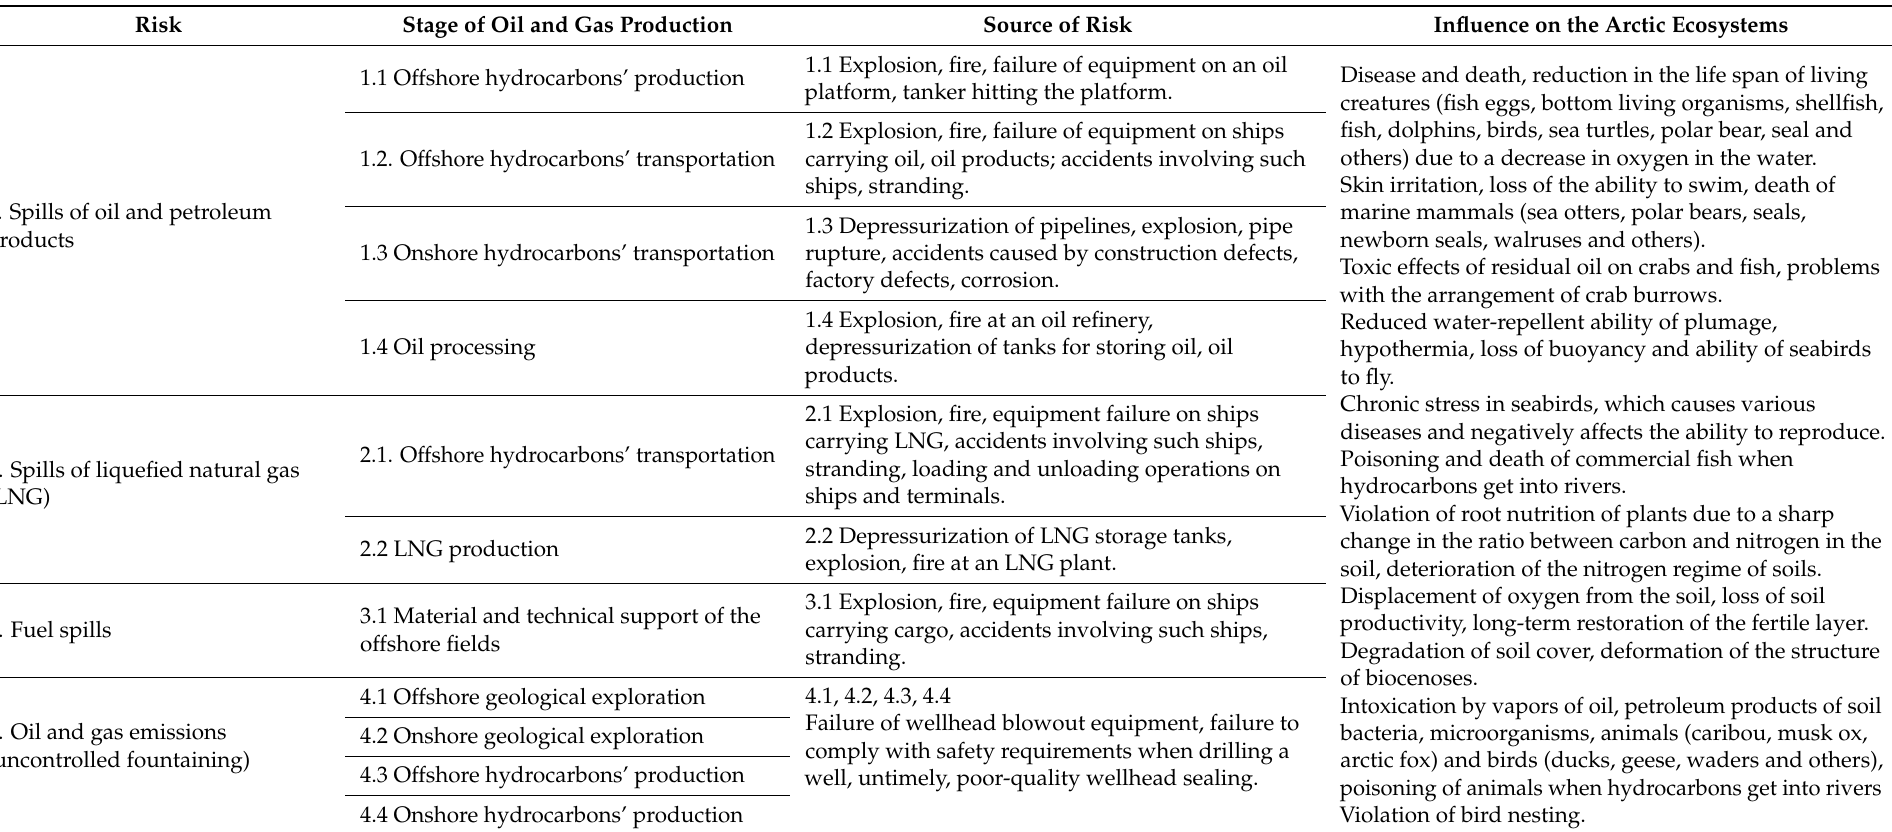
Table 5. Environmental risks register (created by authors, based on